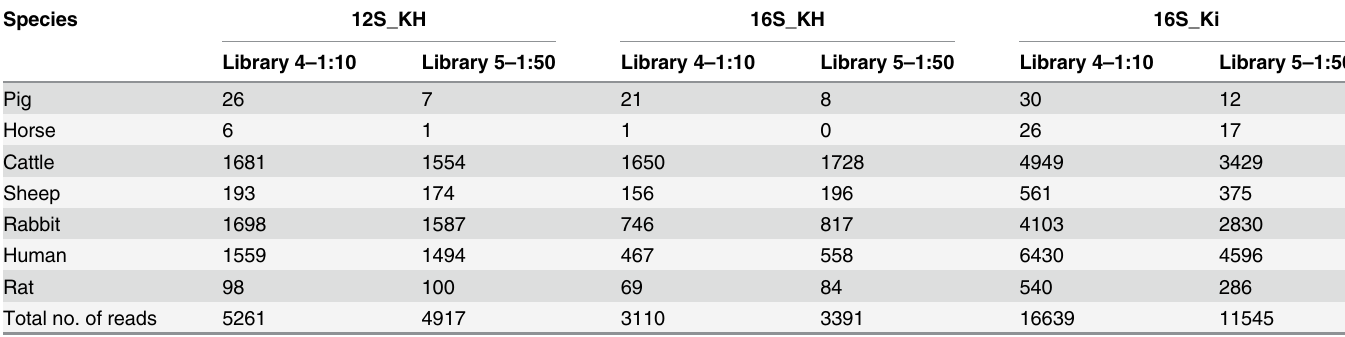
Table 5. Number of mapped reads for each primer pair and species combinations obtained from libraries 4 and 5 in which pig and horse amplicons were obtained from DNA mixtures in which pig and horse DNA was included at 1:10 and 1:50 ratios, respectively.